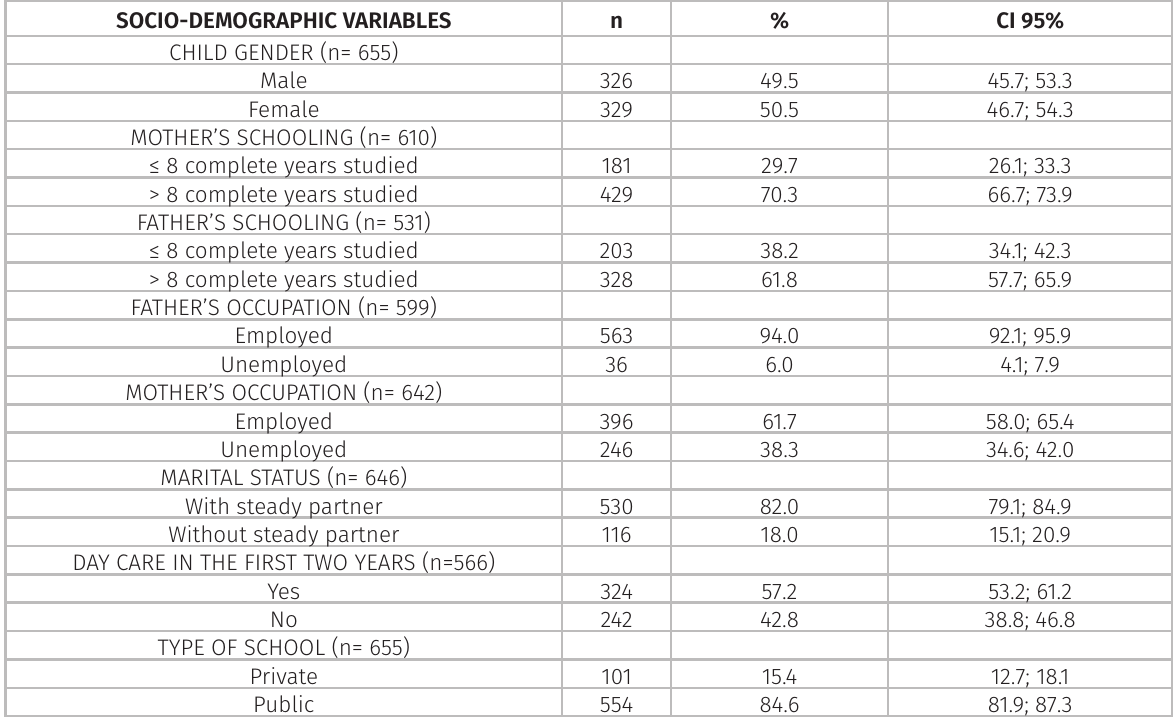
CI 95% = Confidence interval at 95%. Table II. Prevalence of nutritional and non-nutritional habits in 6-year-old schoolchildren. Palhoça/SC, Brazil. VARIABLES n % CI 95% INTERRUPTION OF EXCLUSIVE BREASTFEEDING BEFORE THE 4 th MONTH (n=586) Yes INTERRUPTION OF EXCLUSIVE BREASTFEEDING BEFORE THE 6 th MONTH (n=586)